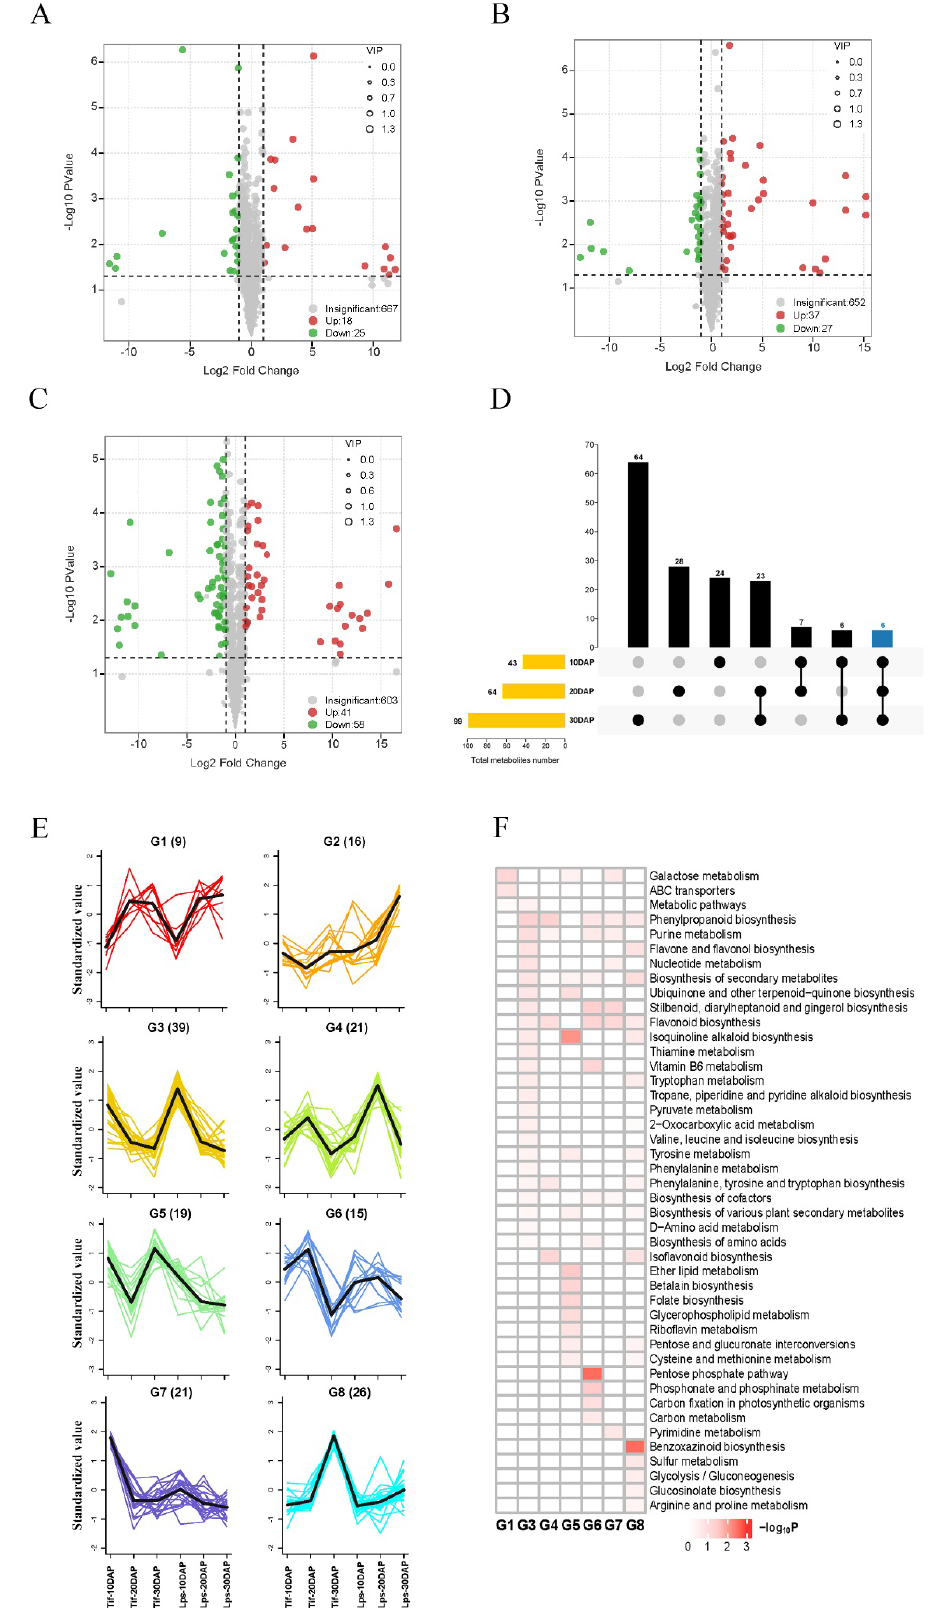
Figure 3. Volcano plots of accumulated metabolites between Tif and Lps ( A ) at 10 DAP; ( B ) at 20 DAP; ( C ) at 30 DAP. Variable importance in projection (VIP) ≥ 1 and |Log2FC| ≥ 1 were considered